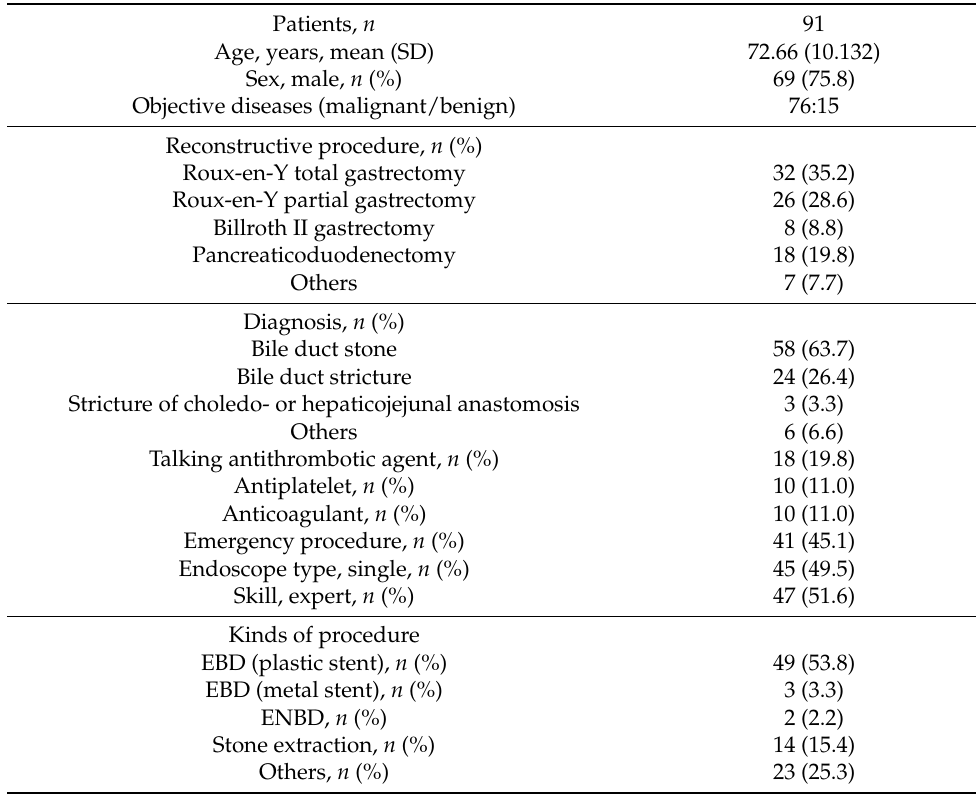
Table 1. Characteristics of patients who underwent endoscopic retrograde cholangiopancreatography